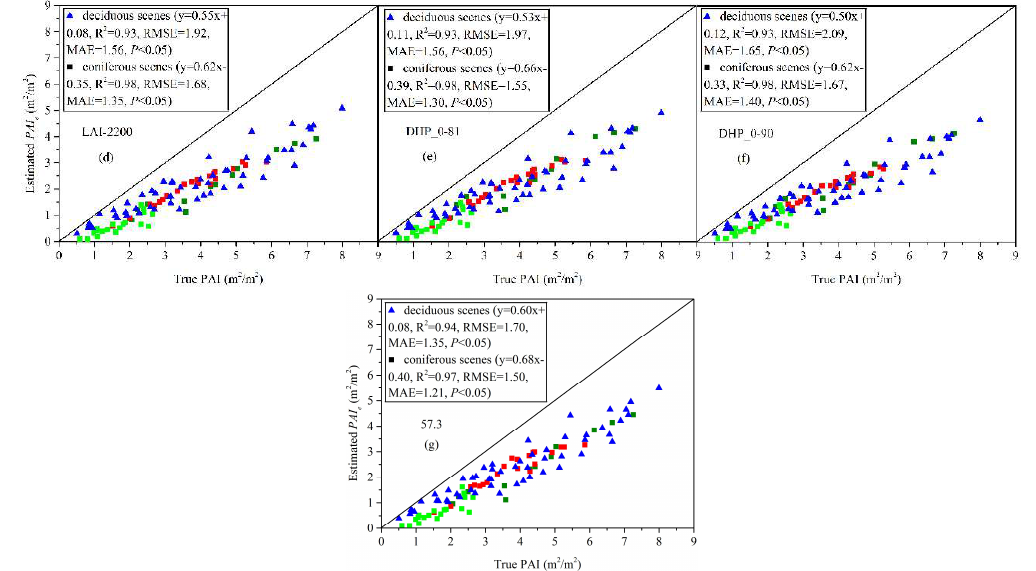
PAI estimates e